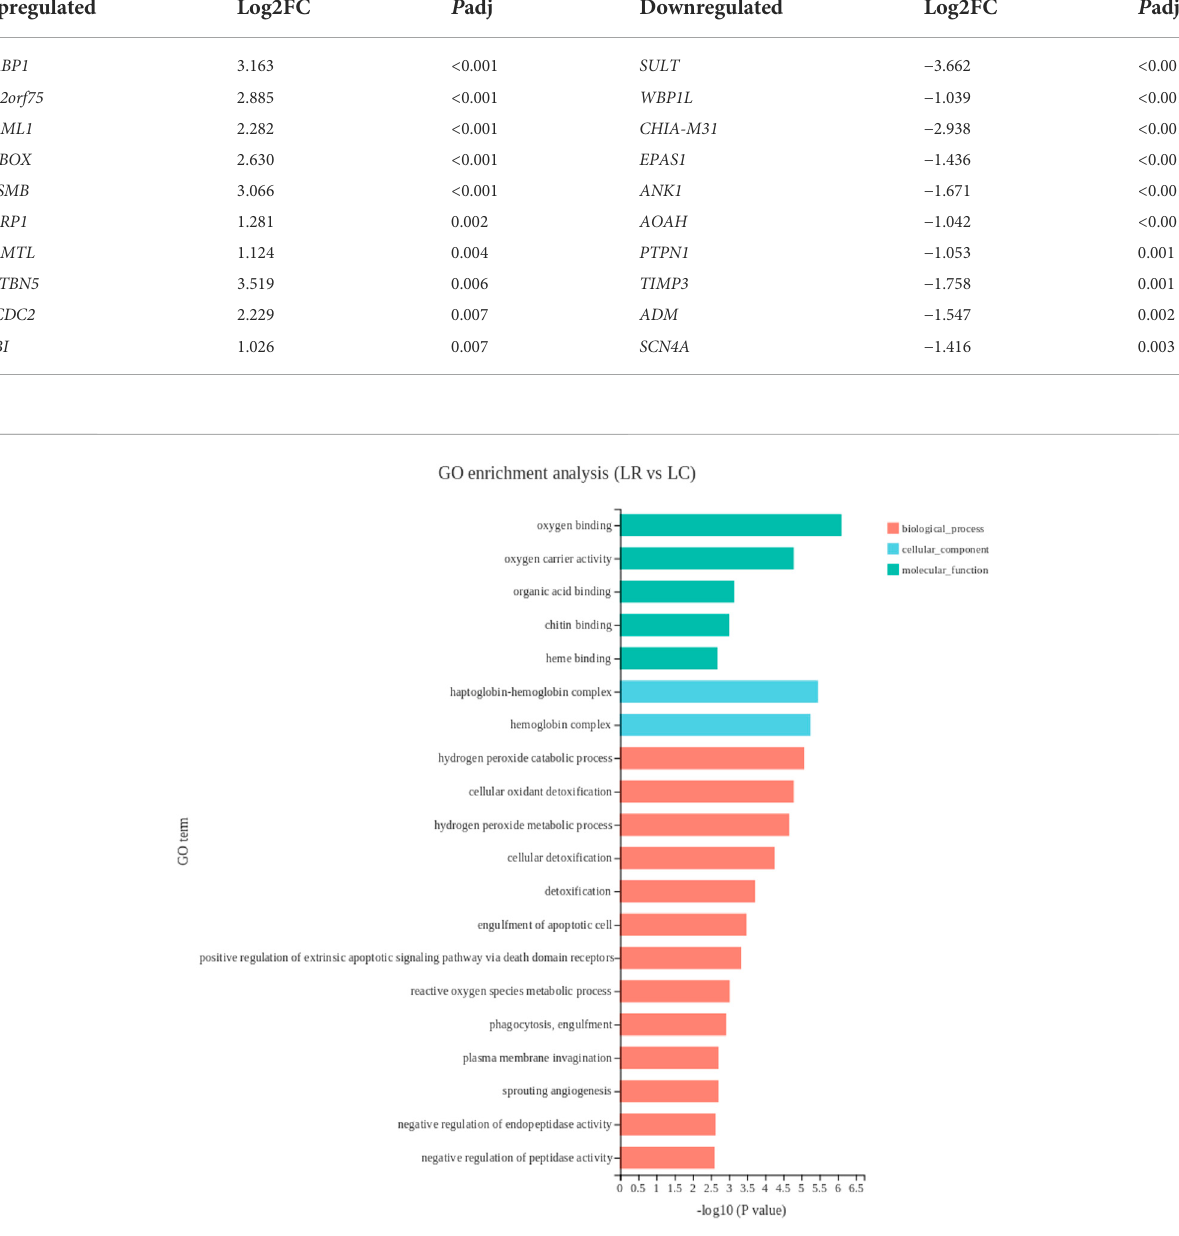
FIGURE 1 The top 20 enriched gene ontology terms of DEGs in liver. The X -axis shows the signi fi cance level of the enrichment, corresponding to the height of the column, where the smaller the FDR and the greater the − log10 ( p -value) value, the more signi fi cantly enriched the GO term; the Y -axis shows the DEG-enriched GO term. LR, liver of rooster; LC, liver of